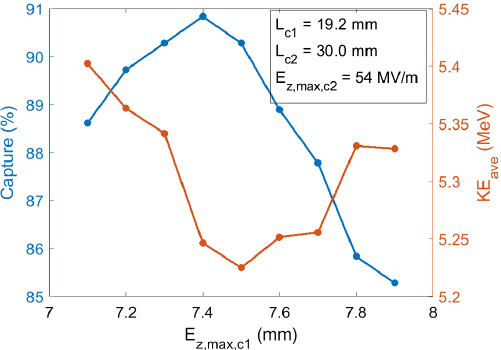
FIG. 6. 1D code fine scan results around high capture and high KE . ave